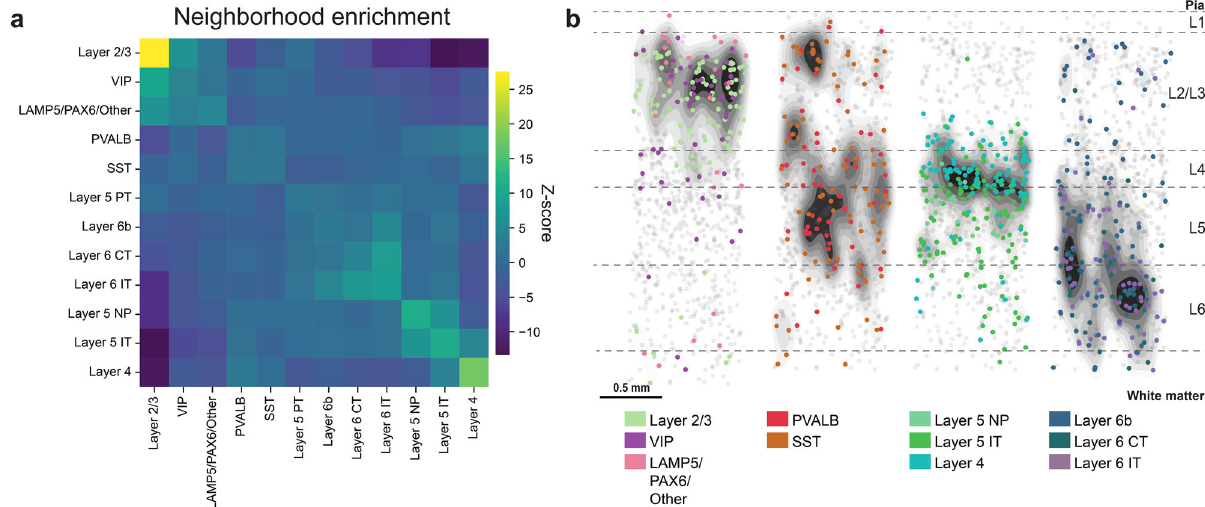
Fig. 3 Neighborhood enrichment analysis of human cell types. a Neighborhood enrichment analysis for neuronal subclasses of all three tissue sections (shown as mean, n = 3 tissue sections). Cluster proximity of subclasses is quanti fi ed with a permutation-based test (1000 permutations), by comparing the actual cell type labels with a random con fi guration of labels and maintaining the positional information. From each pair (actual label vs. label of each permutation), the means and standard deviations are estimated, and a Z -score is calculated. The Z -score indicates if a cluster pair is over-represented or over-depleted in the analysis. b Maps on top of density plots (black) for subclasses from neighborhood enrichment analysis in a , highlighting the increased spatial proximity of the